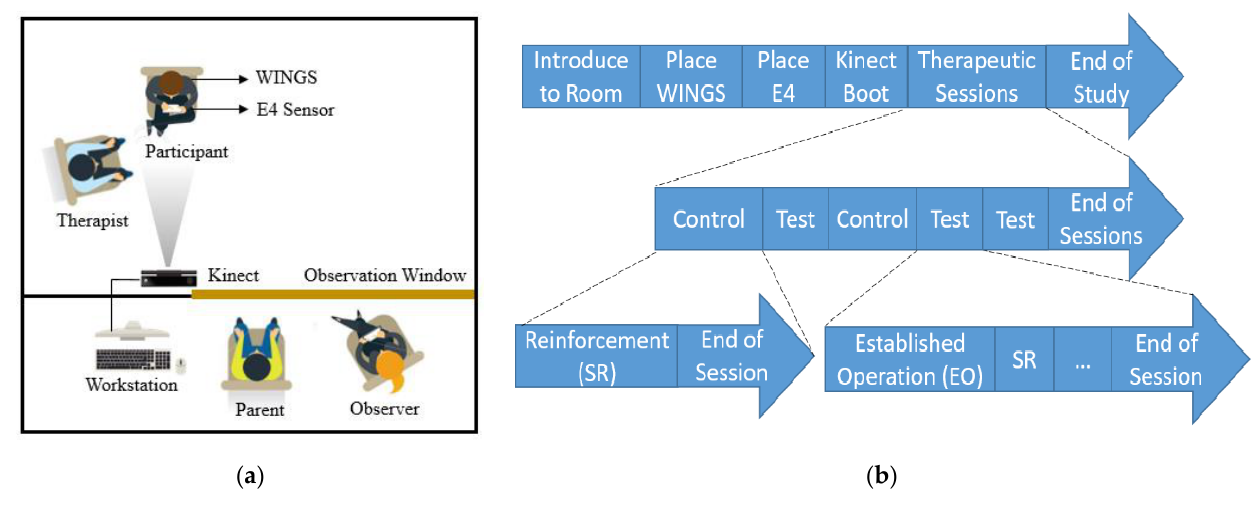
Figure 8. ( a ) Experimental setup; and ( b ) Experimental